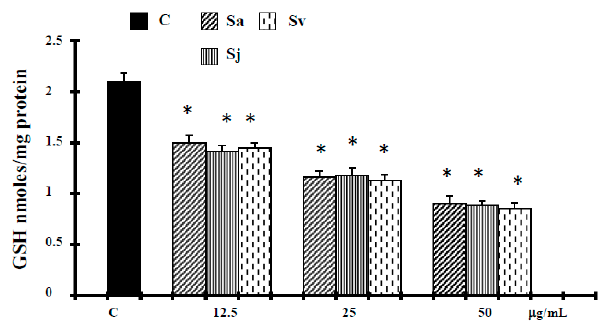
Figure 7. Level of Glutathione (GSH) in DU-145 cells untreated and treated with different concentrations of the essential oils from Sa, Sj and Sv for 72 h. The values are the mean ± standard deviation (SD) of three experiments performed in quadruplicate. *Significant vs. control untreated cells ( p <